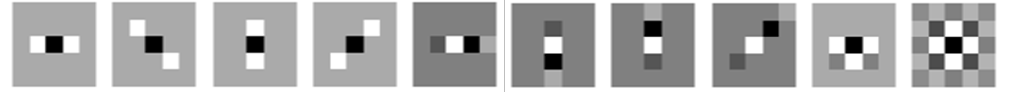
Figure 13. Ten selected SRM filters. They can better detect tiny variation on images, among 30 SRM filters of Figure 3.